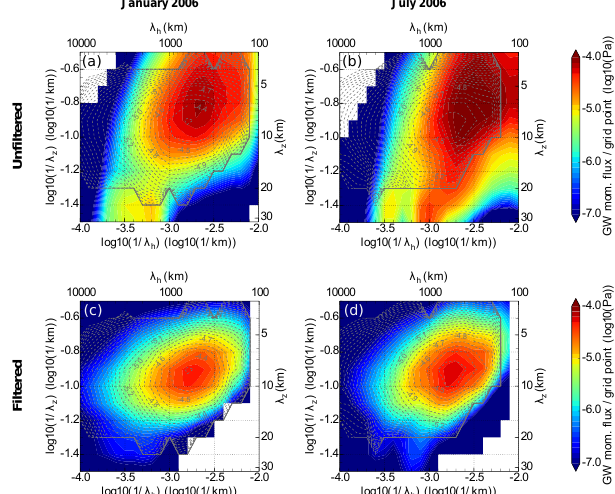
Figure 3. Unfiltered combined GW spectra of selected scale sets for (a) January 2006 and (b) July 2006 and filtered combined spectra of selected scale sets for (c) January 2006 and (d) July 2006. All spectra are shown for the altitude level of 25km. The color code represents combined filtered simulated spectra; the dashed contour lines represent spectra observed by HIRDLS for regions of deep